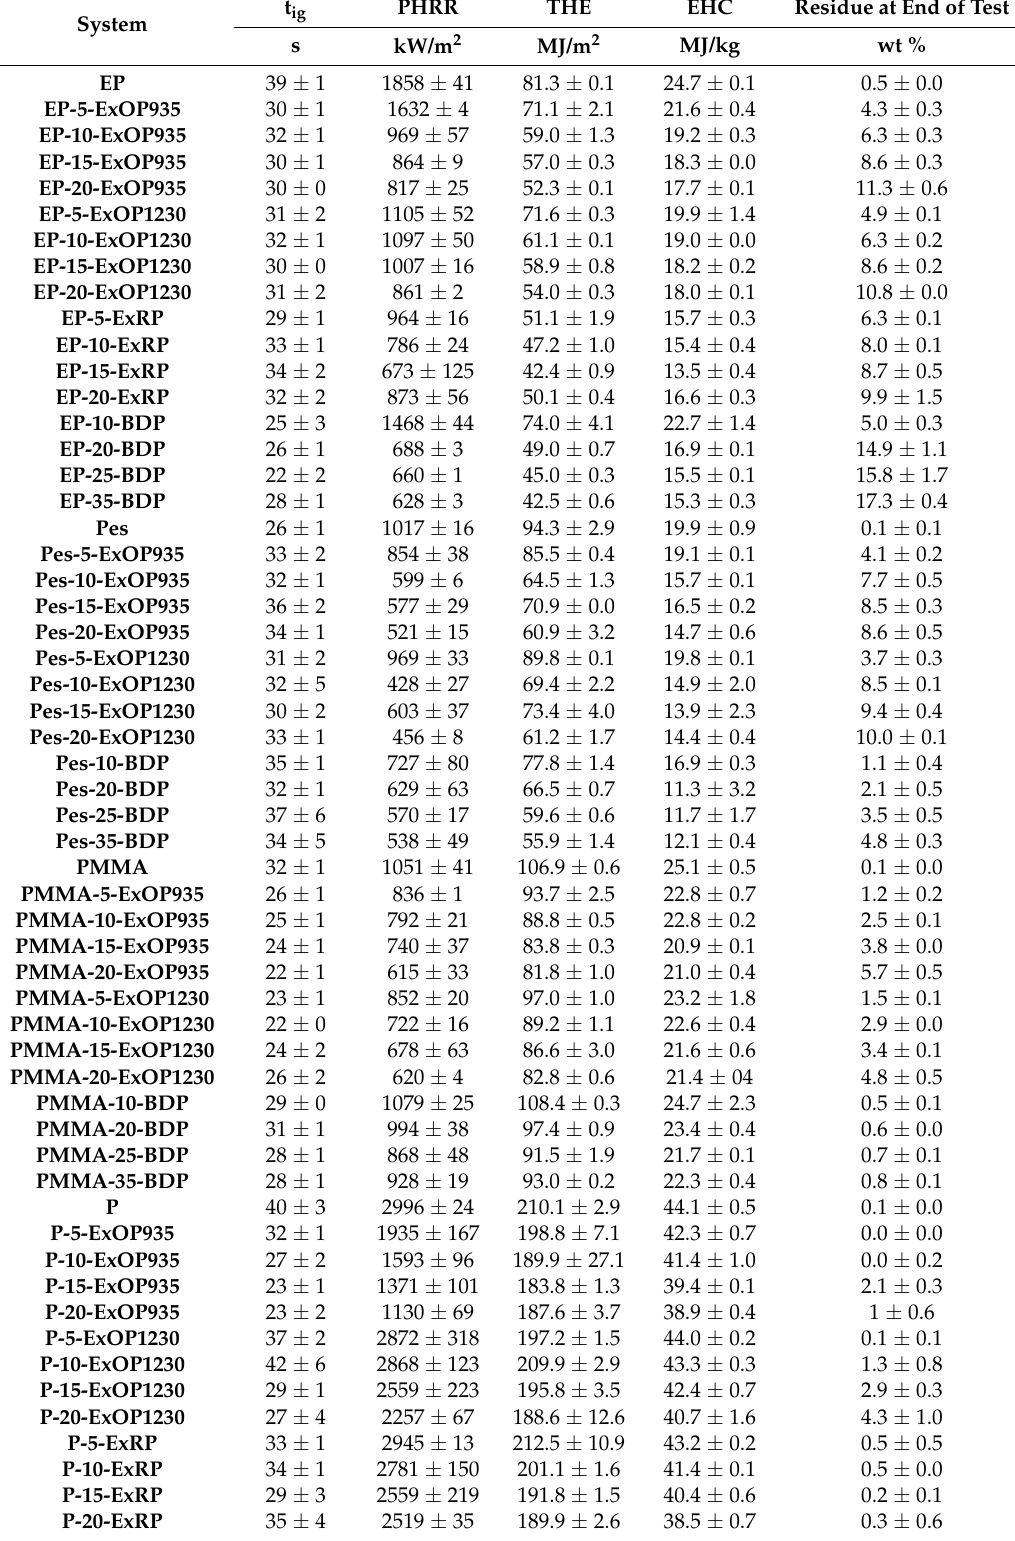
Table 3. Cone calorimeter